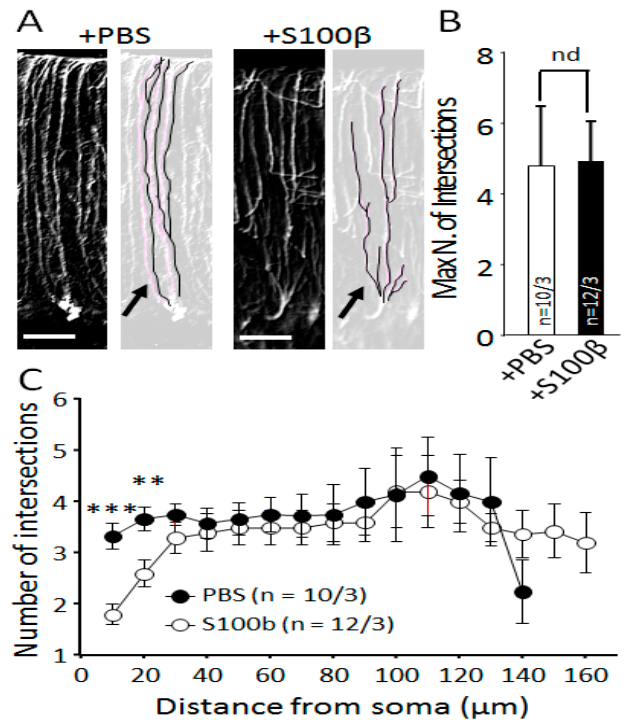
Figure 3. Analysis of Bergmann glia process morphology in PBS and S100 β -injected mice. ( A ) White and black microphotographs of anti-GFAP-labeled areas of cerebellar cortex injected with PBS (left images) and S100 β (right images). Light images contain digitally traced BG processes generated using ImageJ software. Arrows show the proximal processes that were found more often in S100 β injected areas. Scale bar 50 µ m. ( B ) Maximum number of processes per BG cell did not change between PBS and S100 β -injected areas. ( C ) Sholl analysis for PBS- (open circles) and S100 β -injected (closed circles) BG cells (number of intersections per 10 µ m of processes length). ** p < 0.01, *** p < 0.001.